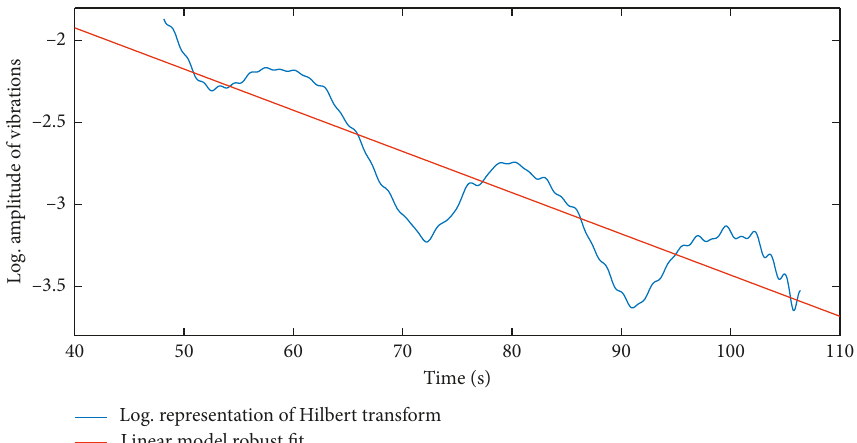
Figure 4: Logarithmic representation of Hilbert transform (blue) and linear estimation (red) (reproduced from [24], under the Creative Commons Attribution-NonCommercial 4.0 International License).